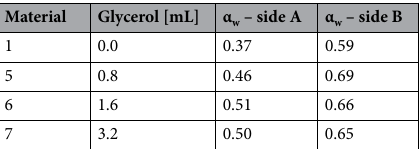
Table 7. Averaged sound absorption coefficient with increasing glycerol concentration.